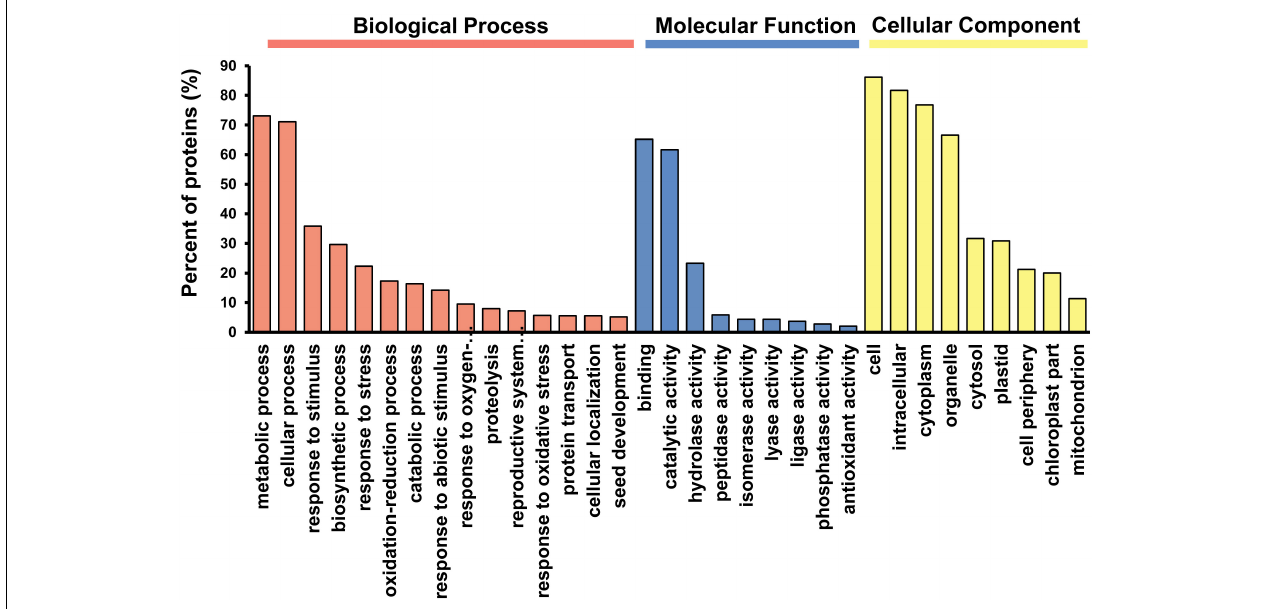
FIGURE 1 | Distribution of the GO (Gene Ontology) categories assigned to the identified proteins from pepper fruit. Proteins were classified according to three categories: Biological Processes, Molecular Function and Cellular Components. After GO term enrichment analysis, the different categories with their corresponding p -values were filtered using the REViGO tool to remove redundant GO